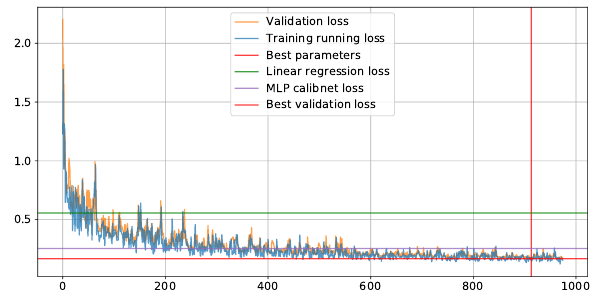
Figure 6. Evolution of training and validation losses during ConvCalibNet network training on datasets Aude1. Green line indicates loss achieved by linear regression, and purple line indicates loss achieved by CalibNet. Red lines indicate best loss and iterations.